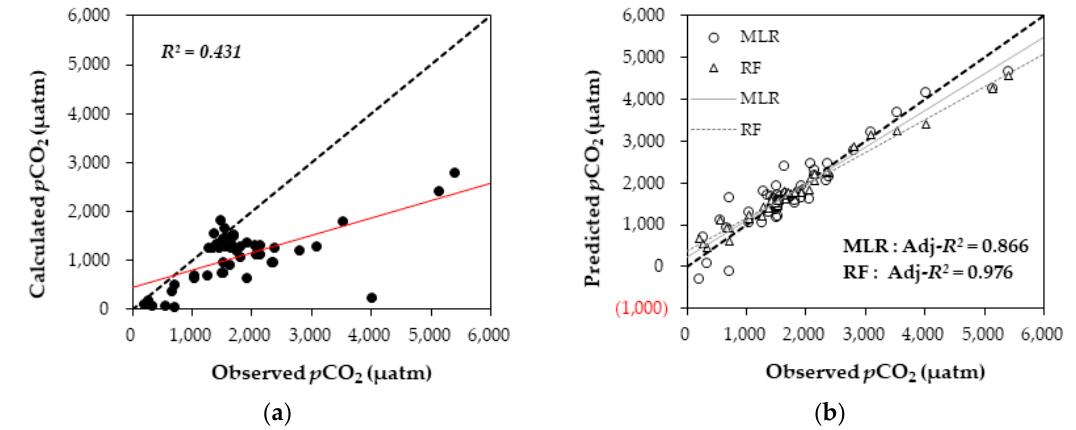
Figure 5. Observed p CO 2 (NDIR method) compared to ( a ) calculated p CO 2 (CO2SYS estimations) and ( b ) predicted p CO 2 (MLR and RF models).